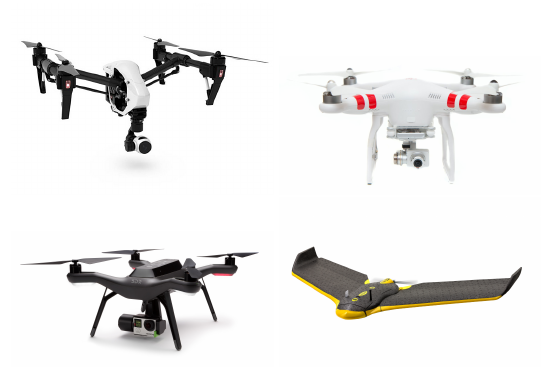
Figure 2: Evaluated drones: DJI Inspire 1 (top-left), DJI Phantom 2 Vision+ (top-right), 3DR Solo with GoPro HERO4 (bottom- left) and senseFly eBee (bottom-right, used as a reference with a global shutter camera).